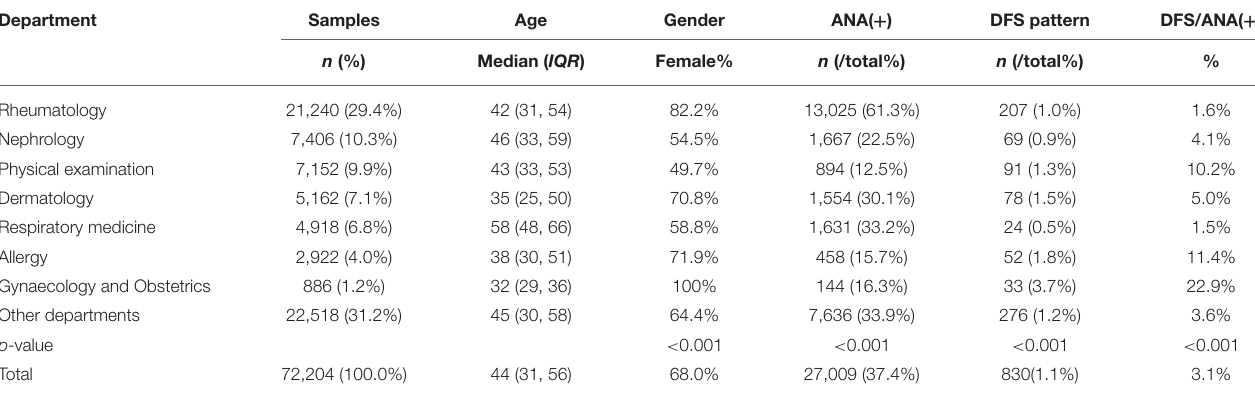
TABLE 1 | Prevalence of ANA positivity and nuclear DFS staining pattern from various departments.